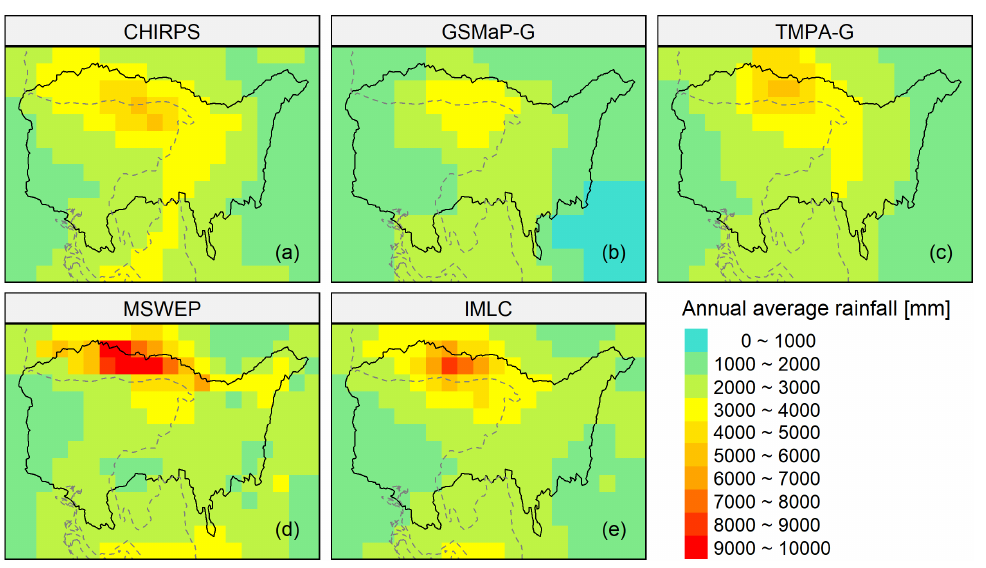
Figure 12. Annual average rainfall distribution at 0.25° grid resolution for ( a ) CHIRPS, ( b ) GSMaP-G, ( c ) TMPA-G, ( d ) MSWEP, and ( e ) IMLC product during the study period (2009–2016).